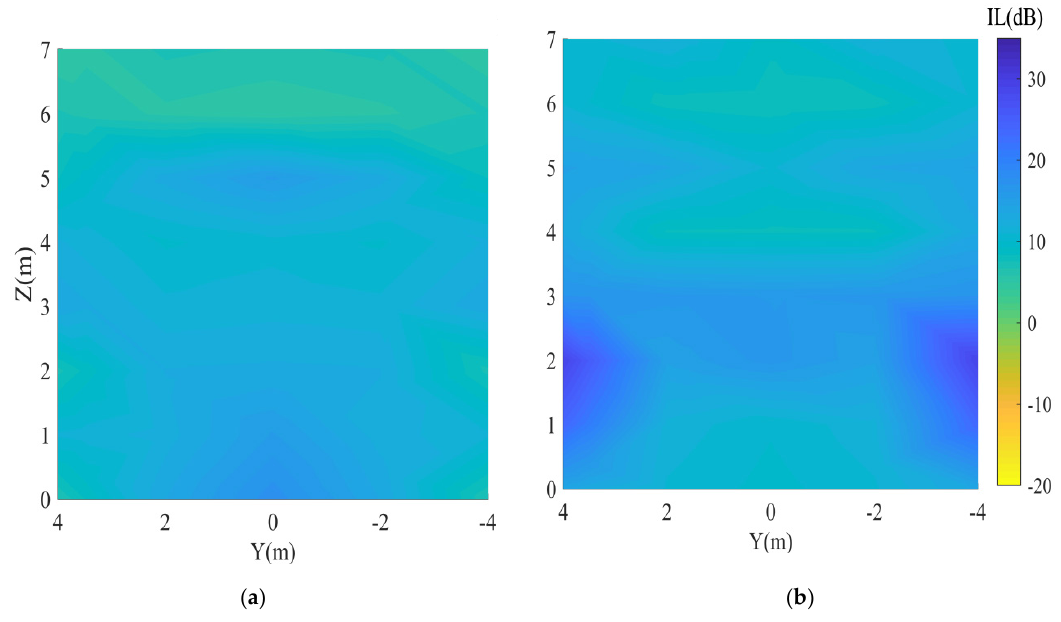
(dB), when , ) = 𝐼𝐼𝐼𝐼� 𝑂𝑂𝐹𝐹 𝑋𝑋 𝑠𝑠 𝑍𝑍 𝑠𝑠